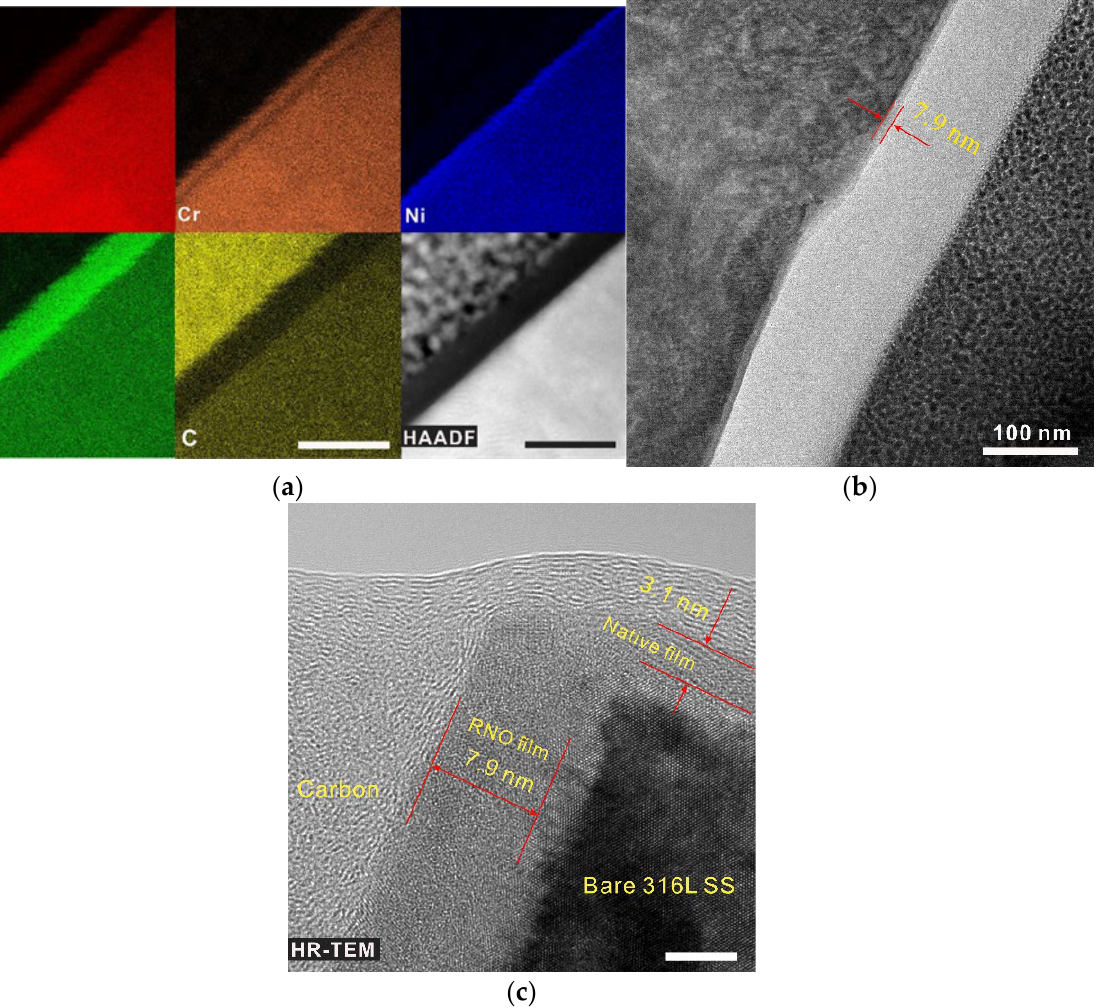
Figure 1. Structure of the RNO film. ( a ) High-angle annular dark-field (HAADF) scanning TEM image with EDS mapping of Fe, Cr, Ni, O, and C distributions within the cross-sectional RNO film on 316L SS after processing for 1 h; ( b ) TEM image of the alloy–film interface at low magnification. ( c ) High-resolution TEM image of the cross-sectional film. Scale bars ( a ), 20 nm, 5 nm.